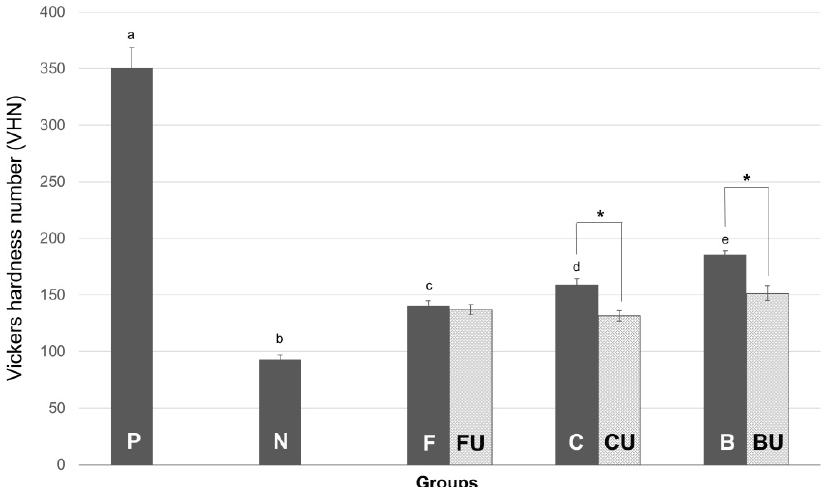
Figure 2. Results of the microhardness test. (n = 20). The unmineralized positive control (Group P) exhibited the highest Vickers harness number (VHN) and Group N the lowest. The VHN of all three varnish groups was greater than that of Group N. Among the three varnish groups, Group B showed the highest VHN, followed by groups C and F. The asterisk (*) indicates statistically significant differences between groups ( P < 0.05)